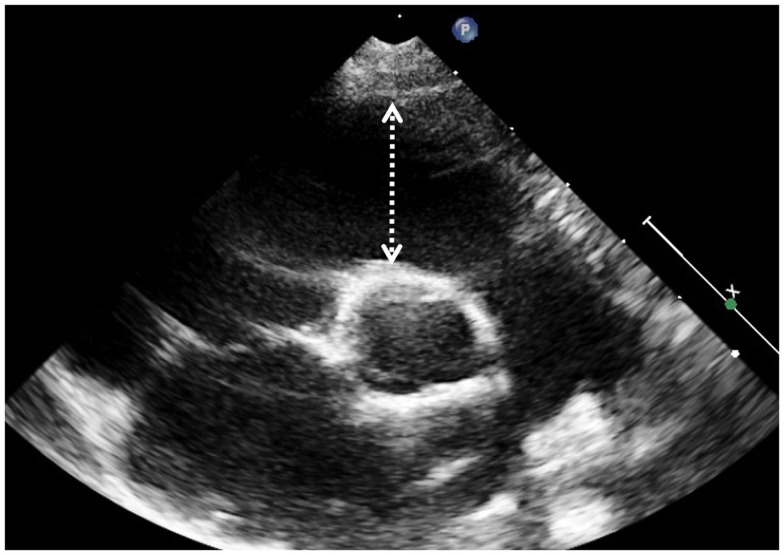
The dotted arrow indicates the position where to measure the RVOT diameter.